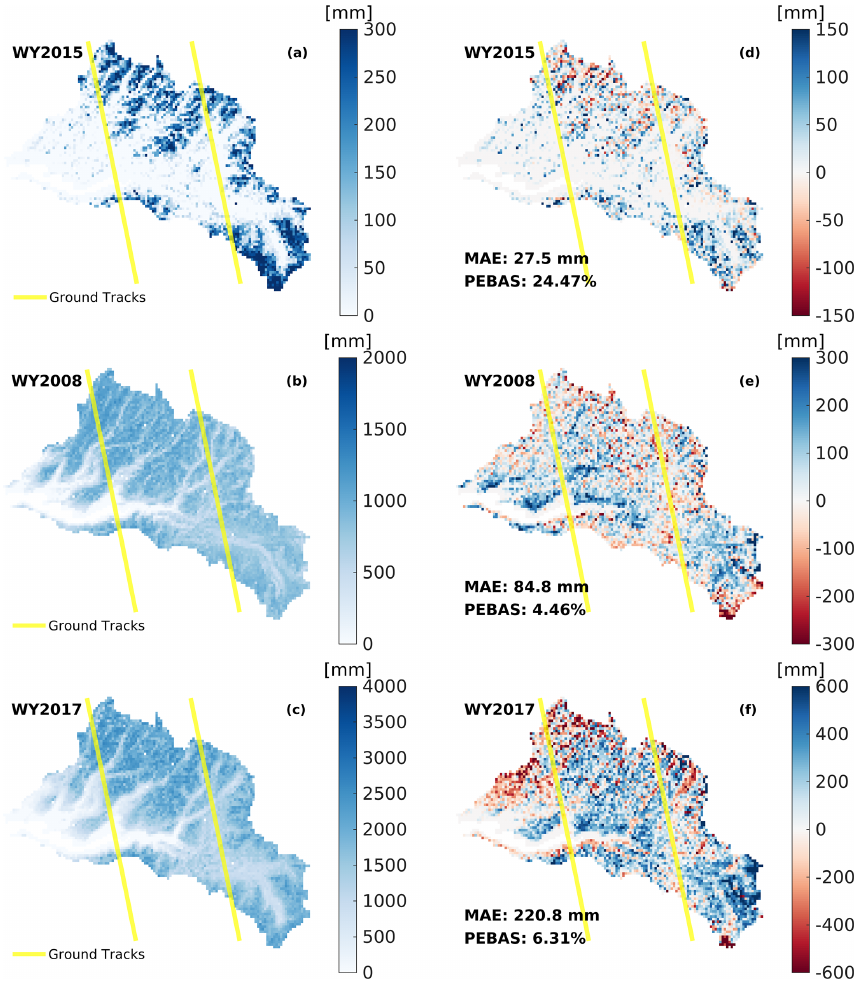
Figure 4. DNN-inferred 1 April SWE maps (a–c) and 1 April SWE errors (estimate minus truth; d–f ) in WY2015, WY2008 and WY2017. Yellow lines are hypothetical ground tracks across the upper Tuolumne watershed, which are approximately 1km wide and the distance between the two tracks is around